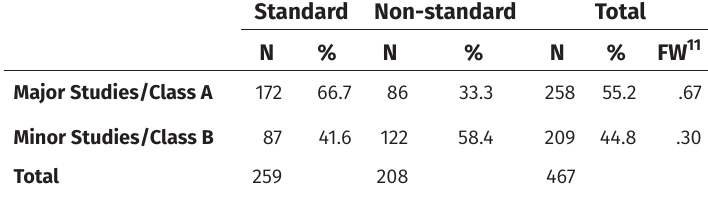
Source : Seixas (2020: